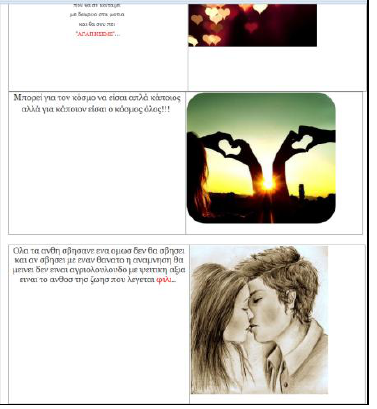
Figure XI. The Poetry site